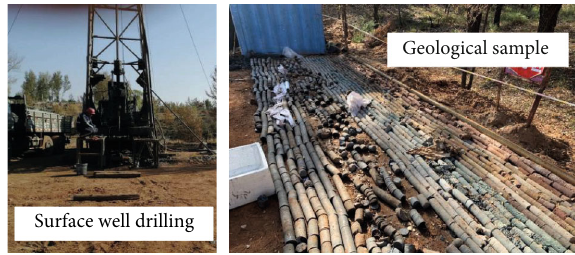
Figure 1: Geological samples at the site.